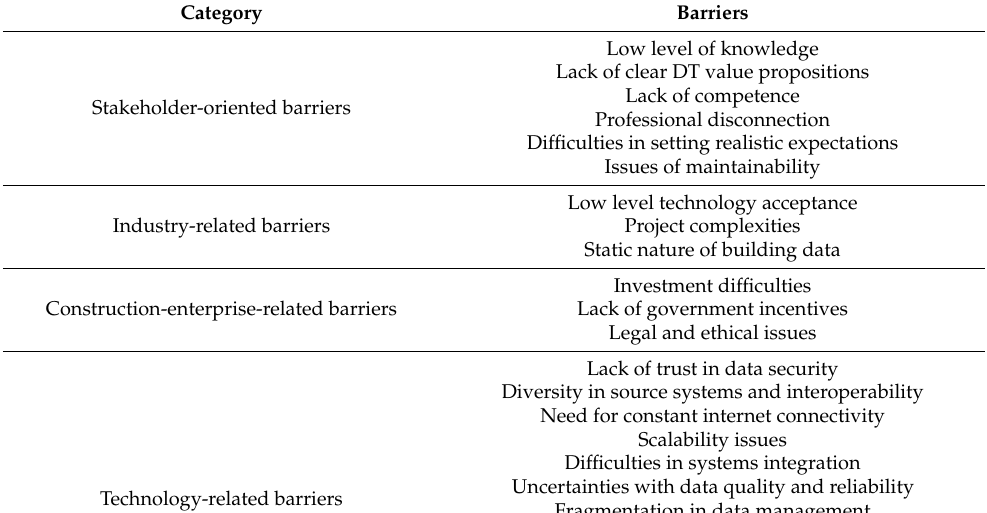
Table 7. Classification of DT adoption in the CI barriers.